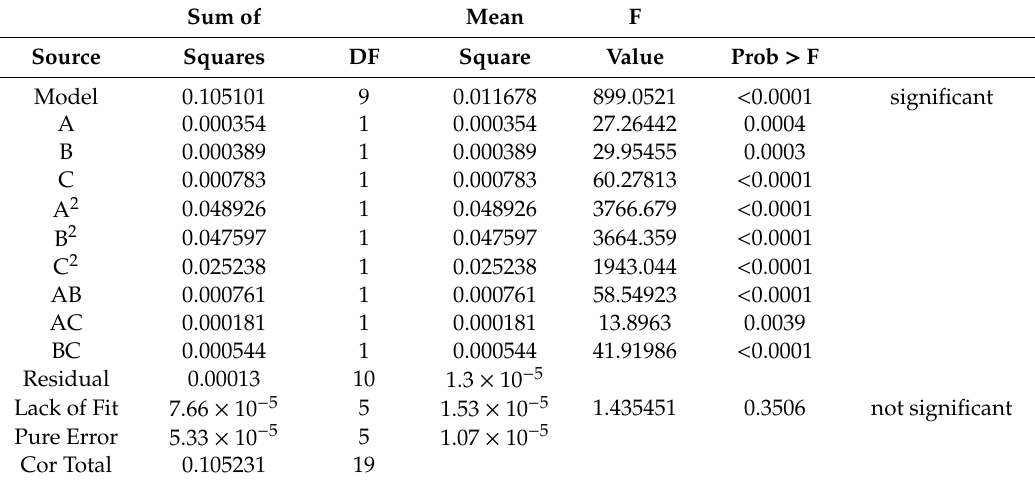
Table 3. Analysis of variance (ANOVA) for the Response Surface Quadratic